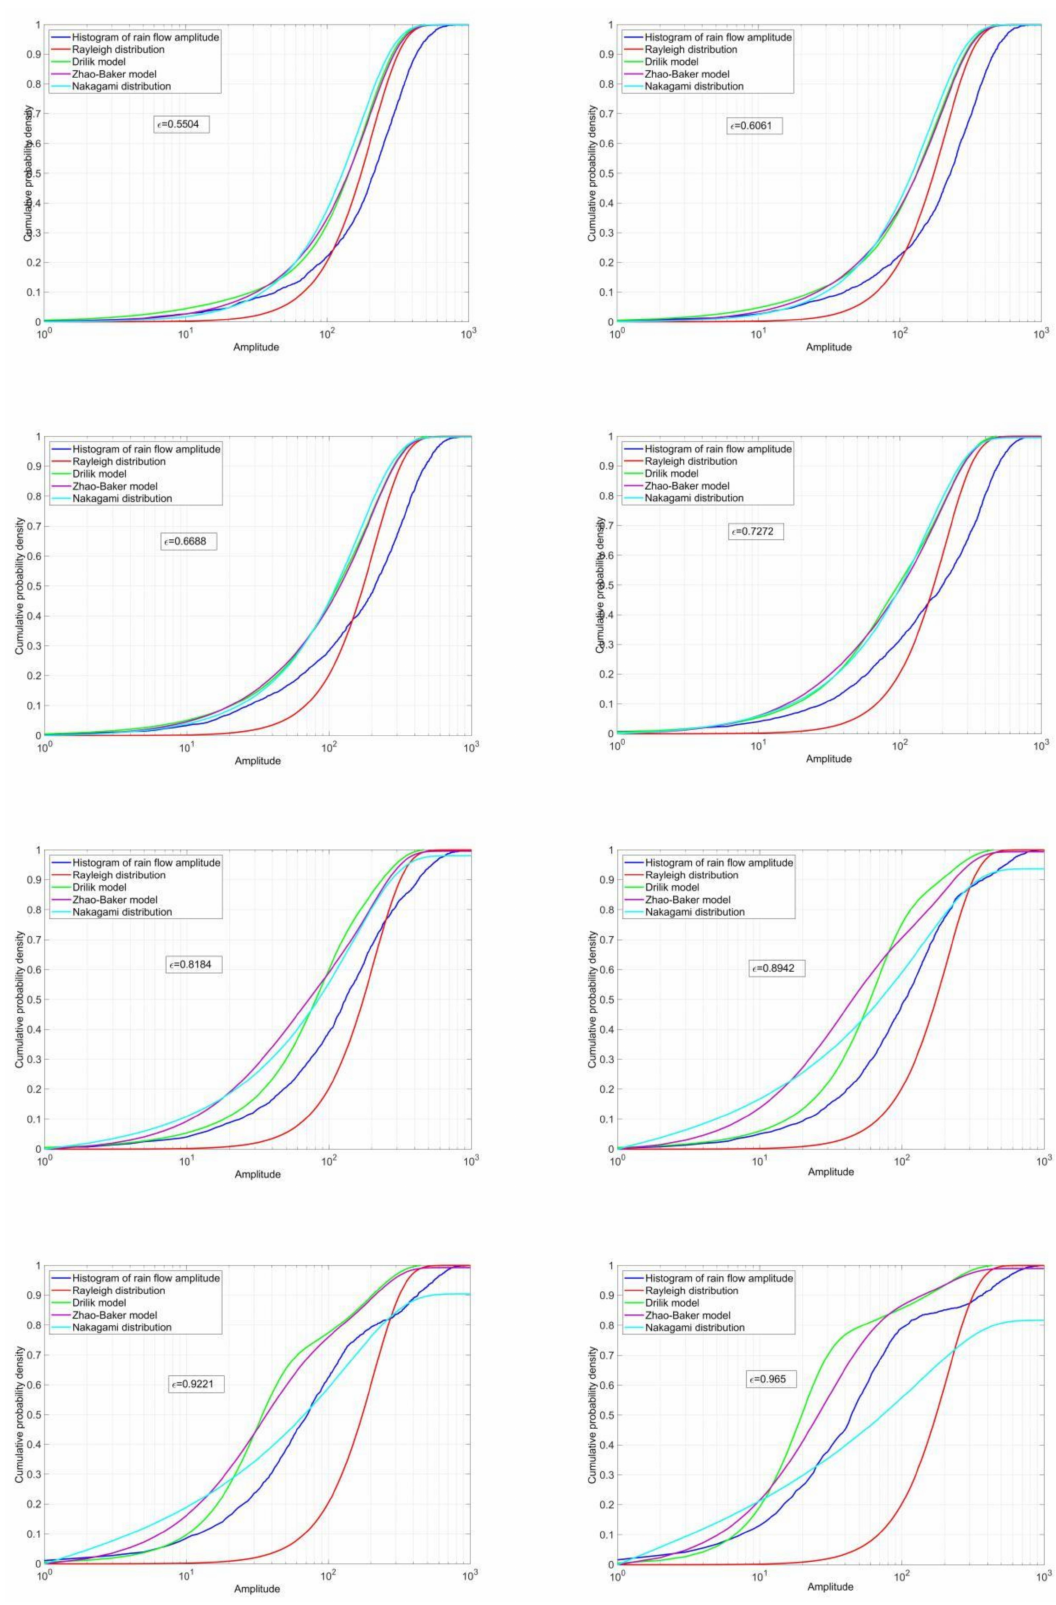
Figure A2. Rain flow amplitude CDF (single peak